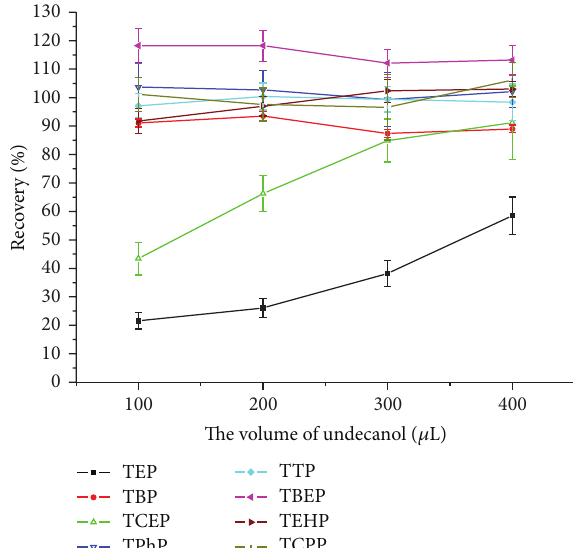
Figure 3: Optimization of extractant volume.